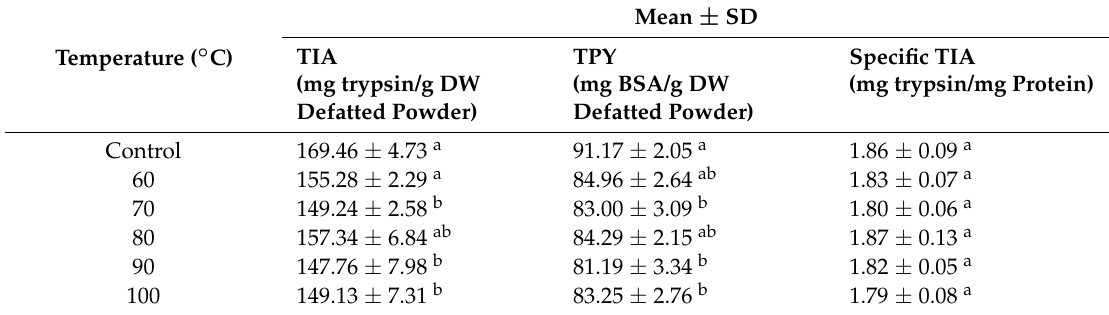
Table 6. Trypsin-inhibitory activity (TIA), total protein yield (TPY) and specific TIA of Gac seed extracts after heating for 10 min at diferent temperatures.